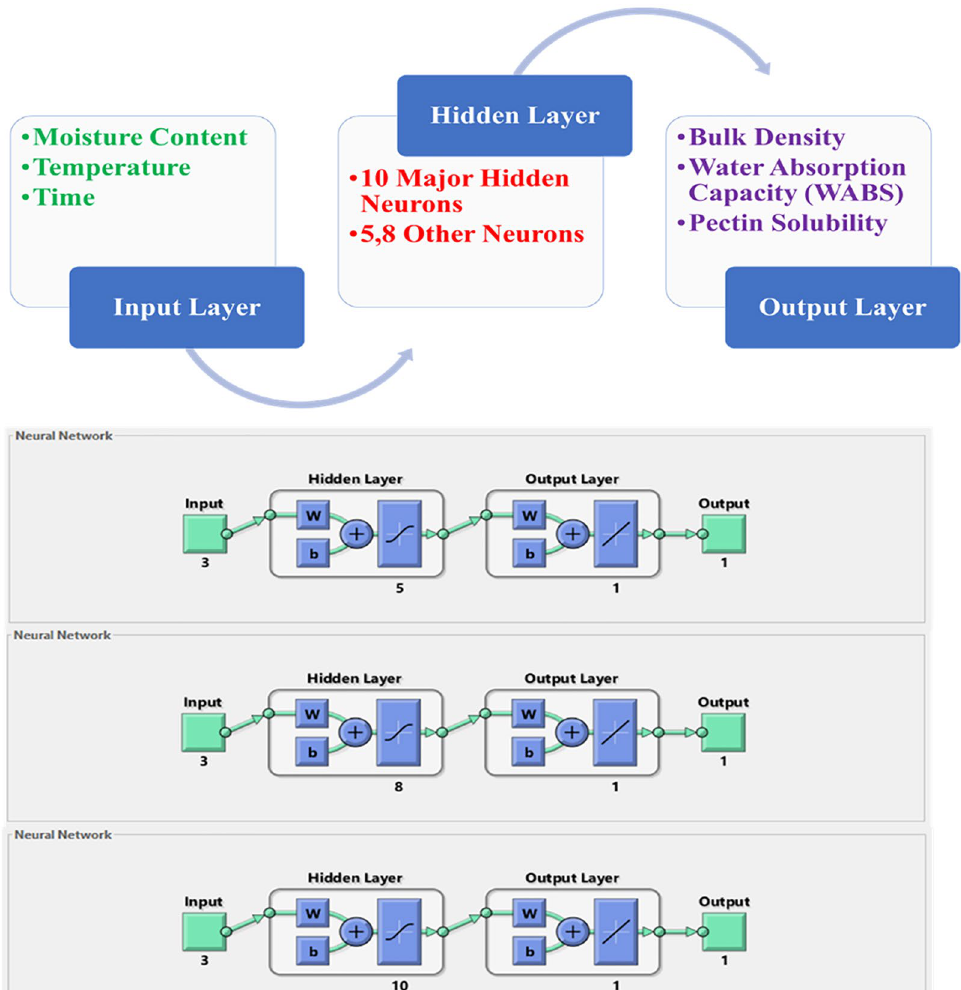
Figure 2. The structure of ANN utilized in the